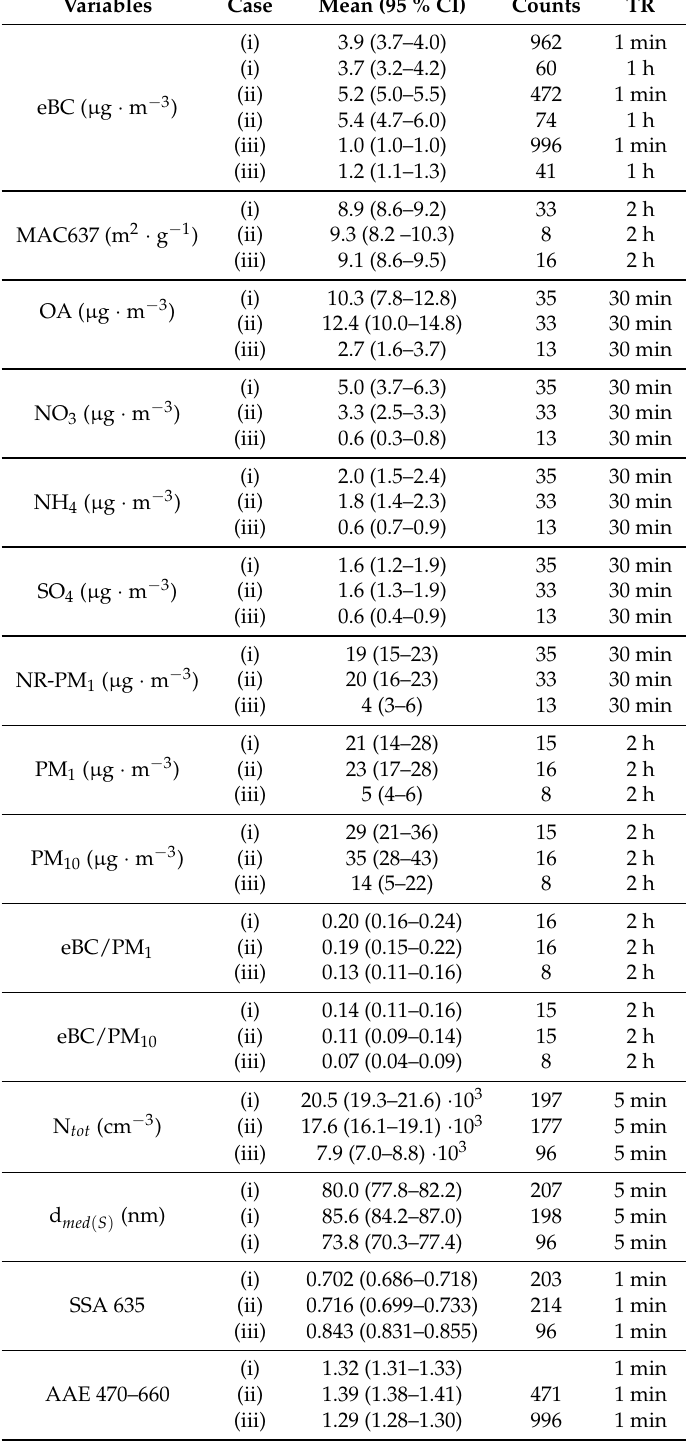
Table 3. Temporal variability of major variables acquired between 2 February 16.00 and 28 February 10:00 2017 at the Rome site, separately shown for (case i) the morning rush hour (08:00 local time) of the working days, (case ii) evening peak (21:00) of the working days, and (case iii) weekends at midday (15:00). Data are presented as mean values and mean 95% confidence internal, relative number of datapoints used in the statistics (counts), and time resolution of data used to calculate the statistics (TR) being